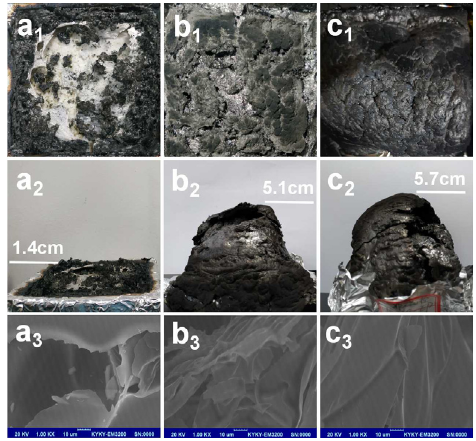
Figure 6. Digital photos and SEM images of residual char after CCTs. Herein, ( a 1 , b 1 , c 1 ) are the top view of digital photos of the pure EP, EP/APP, and EP/APP/INTs-PF 6 -ILs composites; ( a 2 , b 2 , c 2 ) are the side view of pure EP, EP/APP, and EP/APP/INTs-PF 6 -ILs composites; ( a 3 , b 3 , c 3 ) are SEM images of pure EP, EP/APP, and EP/APP/INTs-PF 6 -ILs composites.